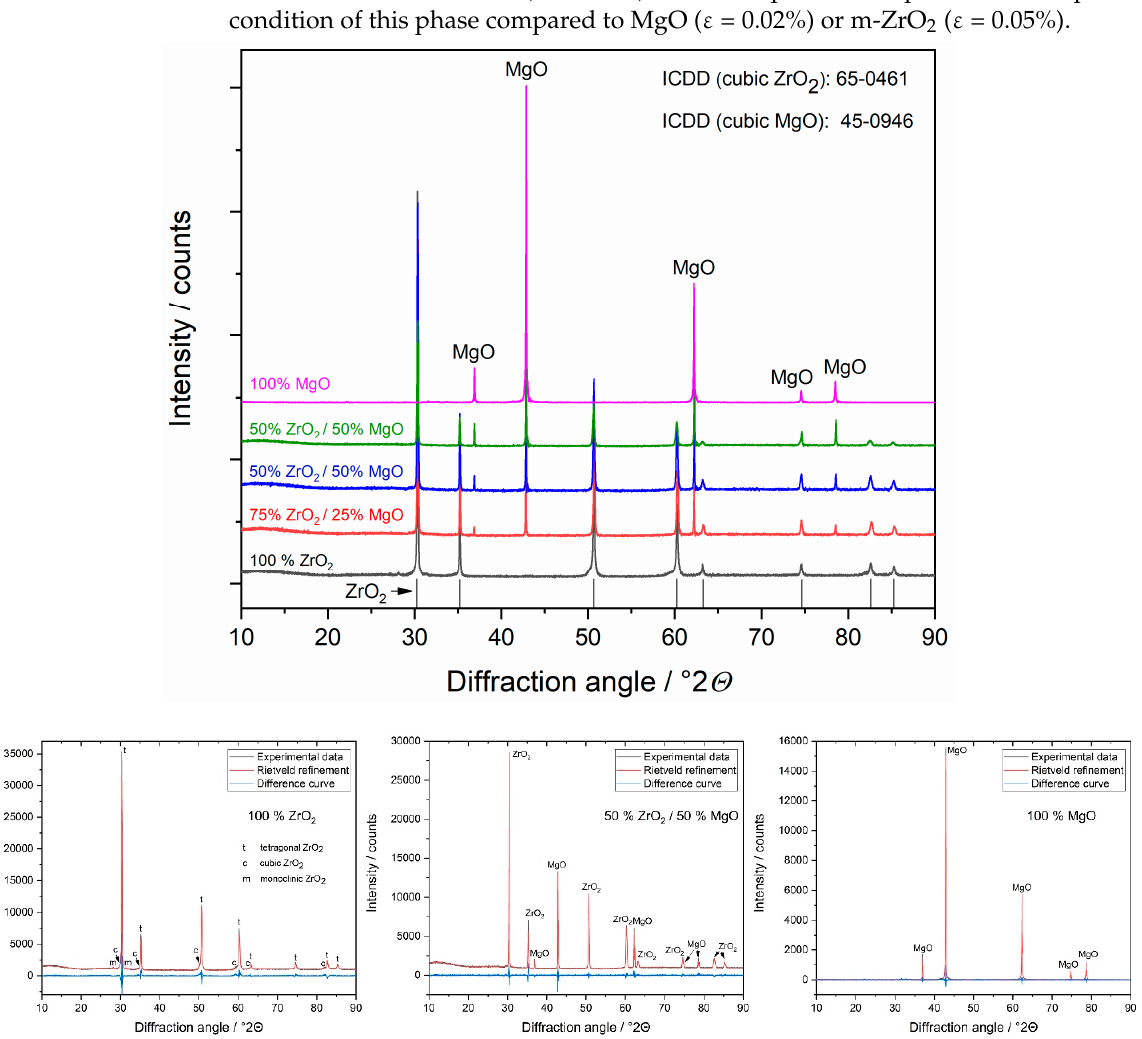
Figure 3. Representative X-ray diffractograms ( top ) and Rietveld refinements ( bottom ) of ZrO 2 /MgO ceramics. The phases were identified using the references from the ICDD database. In the ZrO 2 ceramic different ZrO 2 phases are detectable: tetragonal (t), cubic (c) and monoclinic (m), whereas in the mixed samples only c-ZrO 2. Table 1. Crystallographic parameters determined by Rietveld refinement in XRD for ZrO 2 /MgO ceramics. The porosity of the samples was calculated considering both the density (incl. effect of Zr/Mg substitution) and the weight amount of each phase (see explanation in Figure 4).